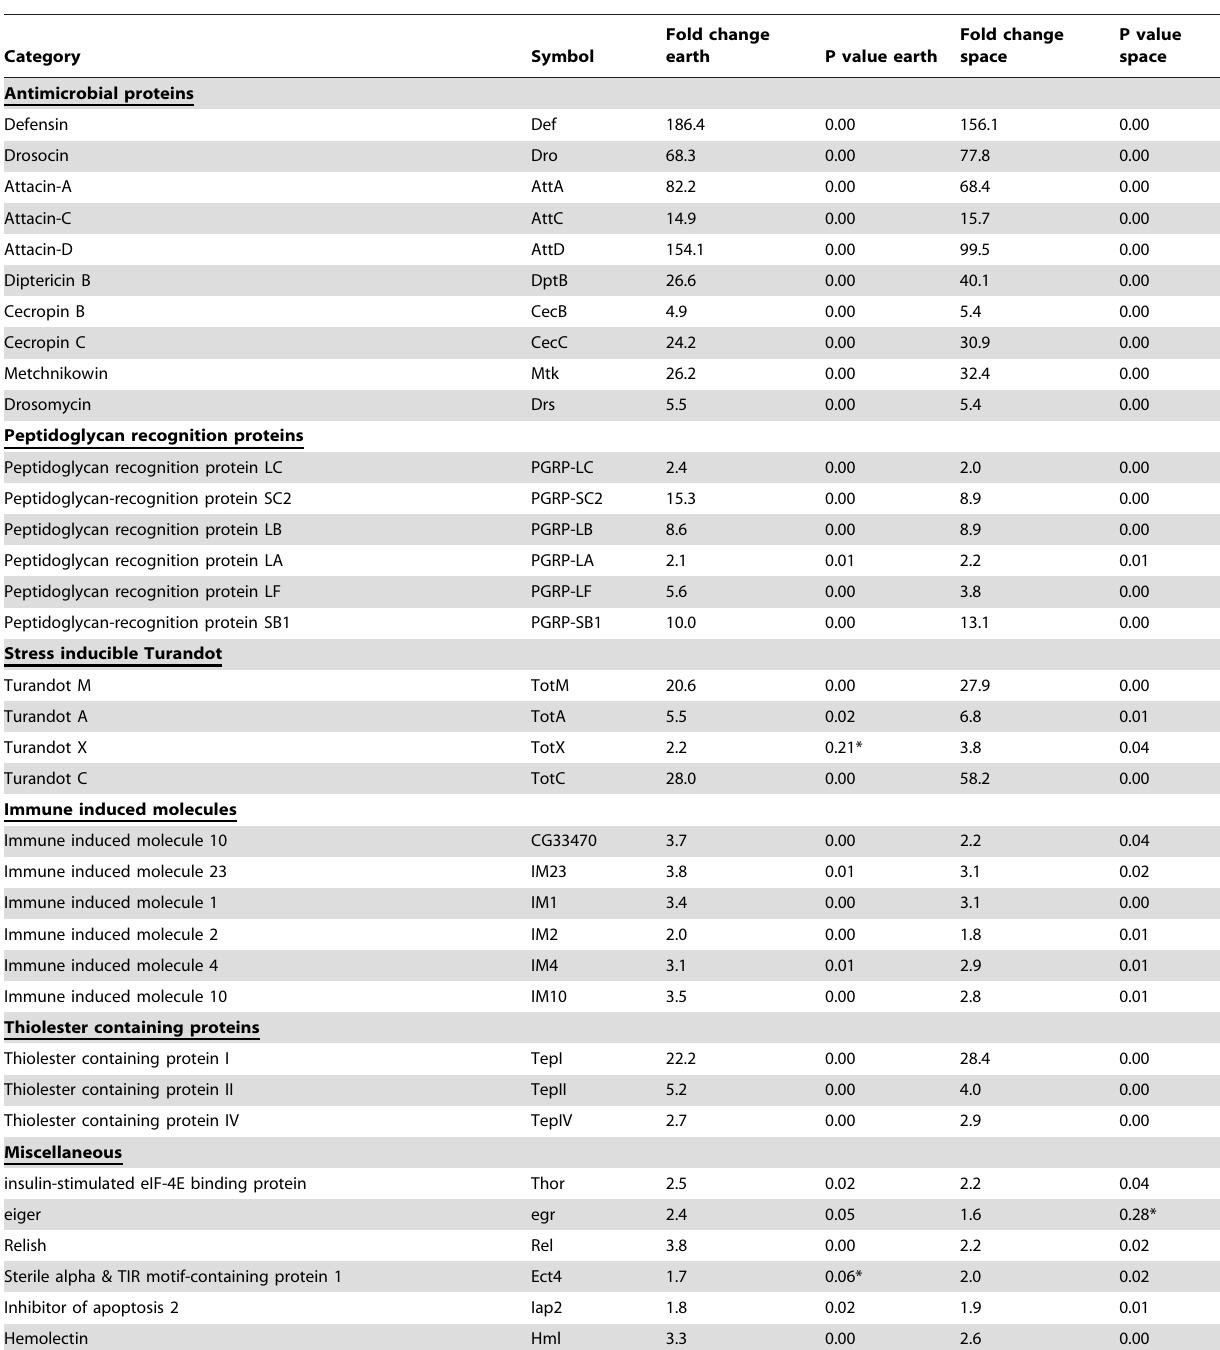
Table 1. Antibacterial response is similar in space and earth flies.